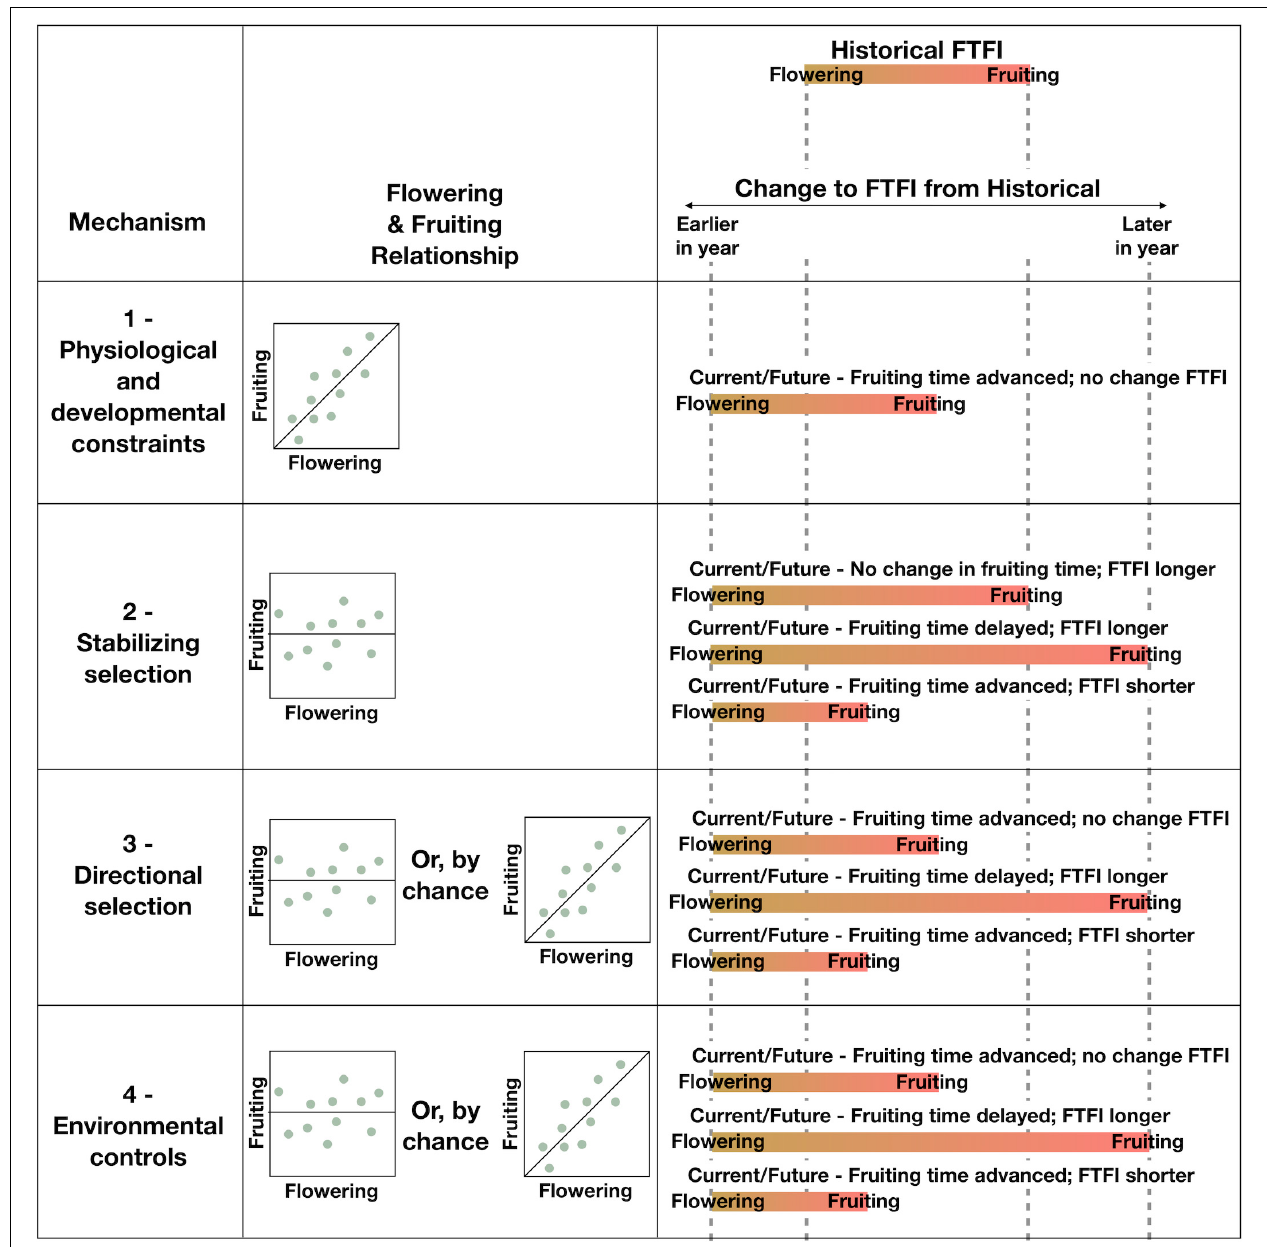
FIGURE 2 | Each proposed general mechanism (column 1) is expected to result in changes to the FTFI (column 3), based on the relationship between flowering and fruiting time (column 2) of single reproductive structures on single individual plants (dots). An internal mechanism results in a tight correlation between flowering and fruiting (Mechanism 1), whereas an external mechanism results in no clear relationship (Mechanisms 2–4). Although Mechanisms 3 and 4 are driven by external processes, these processes could by chance result in a relationship between flowering and fruiting that appears tightly correlated like an internal mechanism. An internal mechanism results in a shift of the FTFI from historical (top of column 3), but the length of the FTFI is preserved. External mechanisms result in several possible changes to the FTFI from historical wherein timing of flowering, fruiting, or both are altered. Bars represent the beginning of the flowering stage (yellow) to the fruit maturity stage (red) for a single reproductive structure on a single individual. Advanced flowering is represented by the dashed line labeled as earlier in year, and delayed fruiting is represented by the dashed line labeled as later in year. Historical flowering and fruiting times are represented by the two central dashed lines. All possible options for changes to fruiting, given advanced flowering currently and in the future, are displayed for each